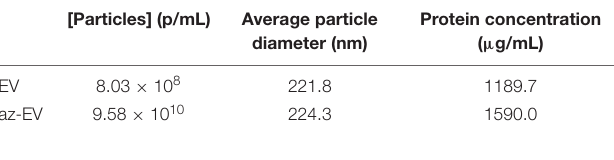
TABLE 1 | Size and protein characterization of unmodified and azide tagged